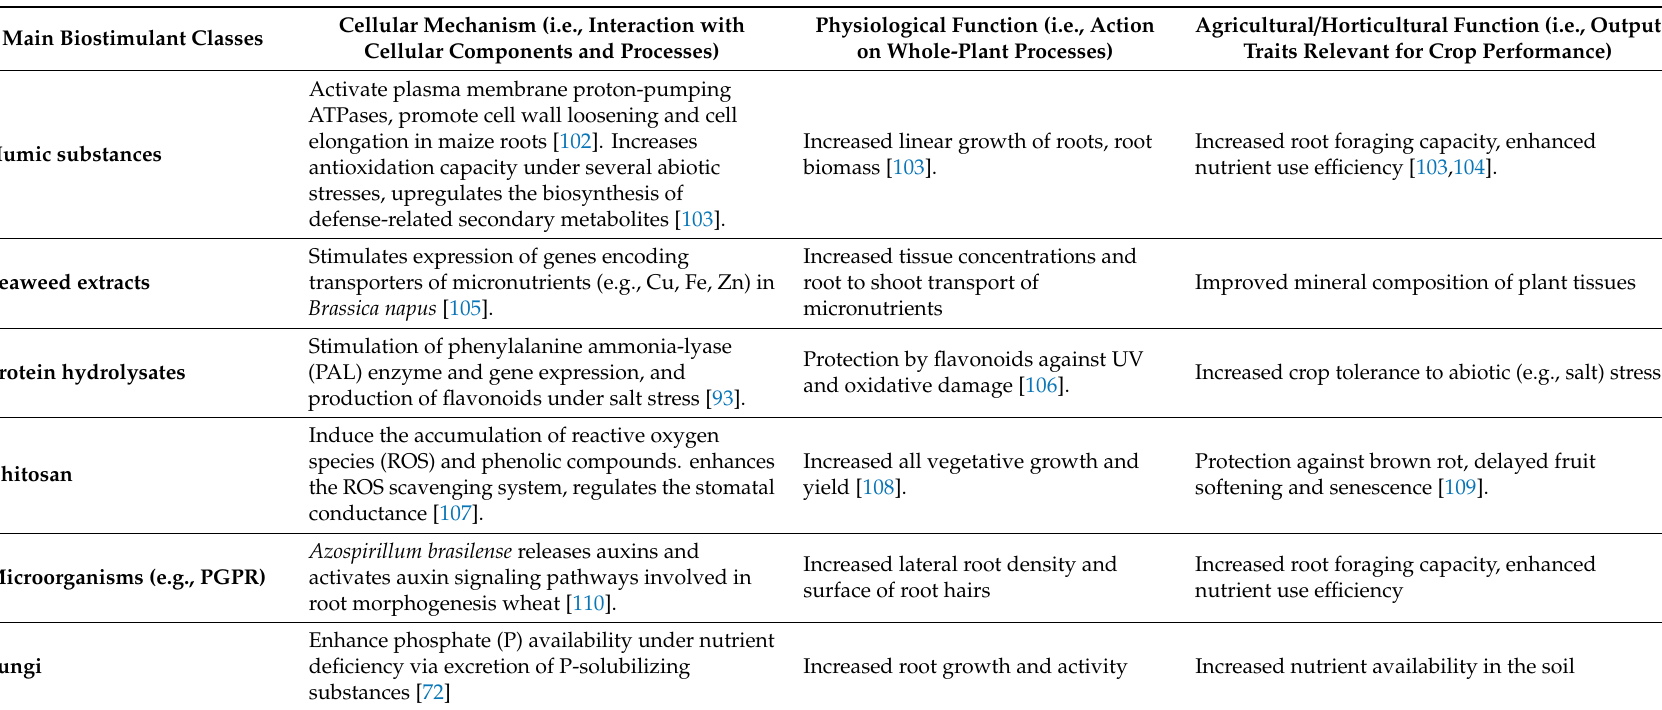
Table 1. The e ff ects of biostimulants on crop productions . The table provides some examples whereby cellular and physiological mechanisms underlying the e ff ects of the selected biostimulants under various stresses were demonstrated as well as their agricultural / horticultural functions and the expected economic and environmental benefits (adapted from du Jardin